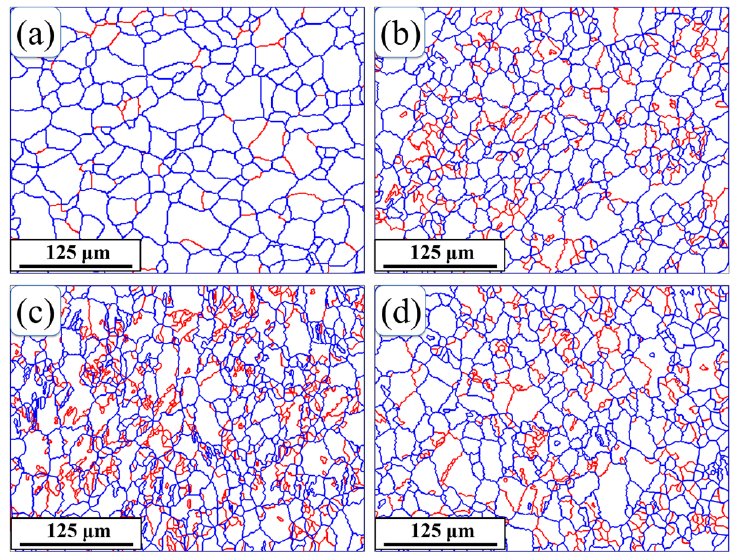
Figure 4 Maps of grain boundaries obtained from EBSD measurement in NiTi SMA samples subjected to various deformation degrees: ( a ) 0%; ( b ) 20%; ( c ) 30%; ( d ) 40%. The blue lines represent grain boundaries whose misorientation is greater than 15 ◦ and the red lines stand for grain boundaries whose misorientation ranges from 5 ◦ to 15 ◦